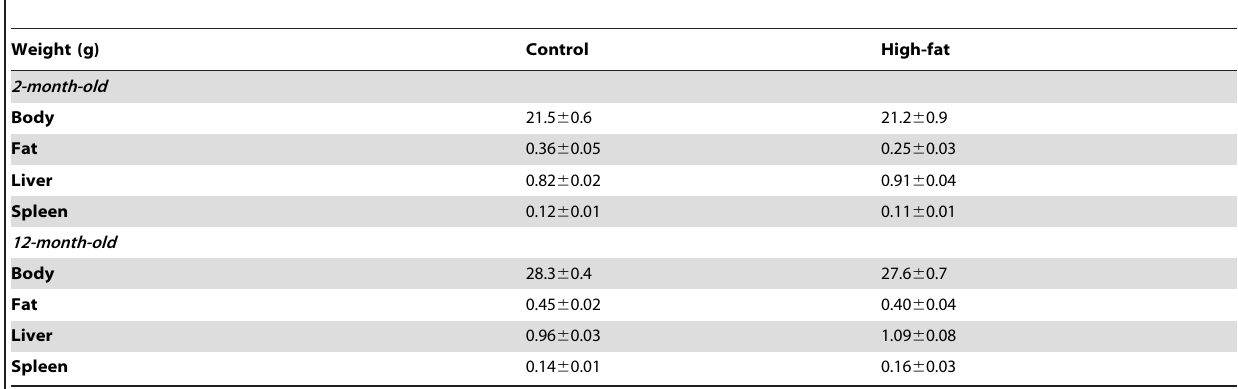
Body, fat (gonadal), liver and spleen weight were measured in separate groups of 2- or 12-month-old female 3xTgAD offspring mice from dams fed either a control or high-fat diet throughout gestation and lactation. Data are mean 6 SEM, n =5/group. Student’s t